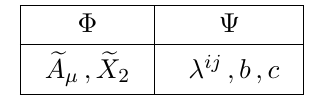
Table 1 . The elementary variables (5 bosons and the 5 fermions) in the cohomological represen- tation of the vector multiplet (cid:12)elds, including the ghost system. The rest of the (cid:12)elds are in Q eq variations of the elementary variables.